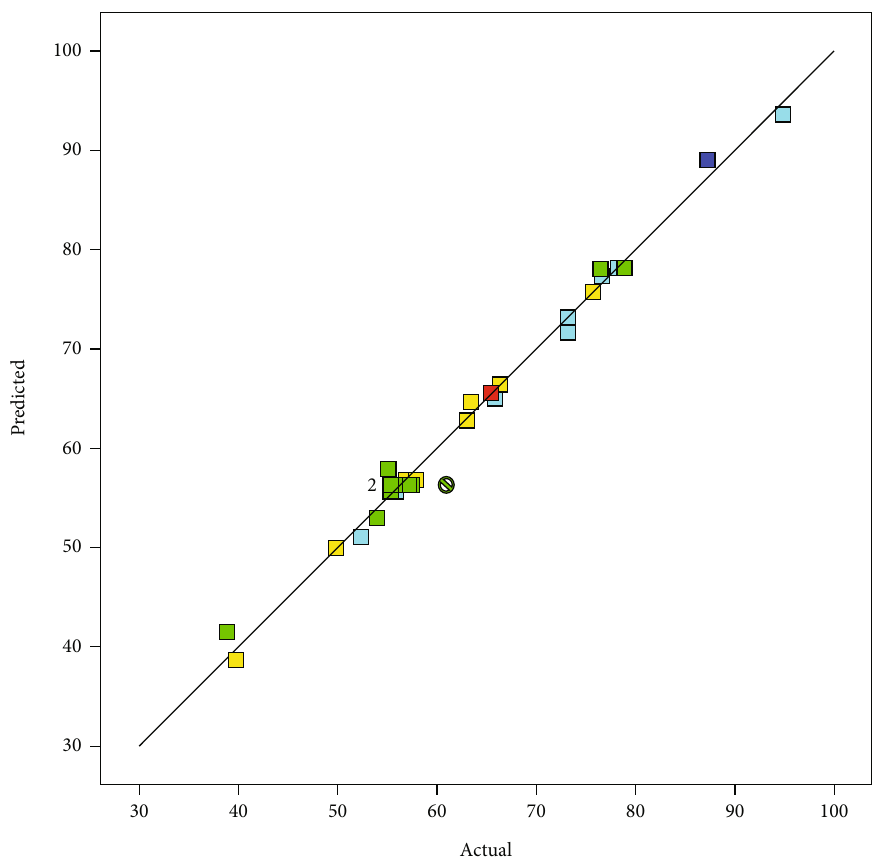
Figure 5: Predicted vs. actual values of